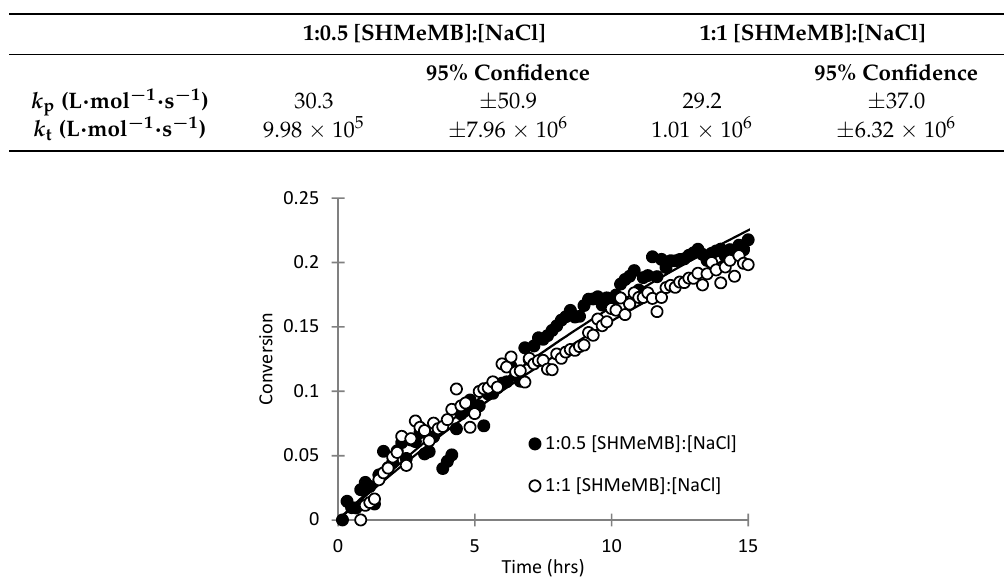
Figure 10. Monomer conversion profiles from homopolymerization of SHMeMB with different concentrations of added NaCl salt at 75 °C with 1 wt % V-86 and 15 wt % monomer. The solid lines represent the simulated conversion profiles using parameter estimation.